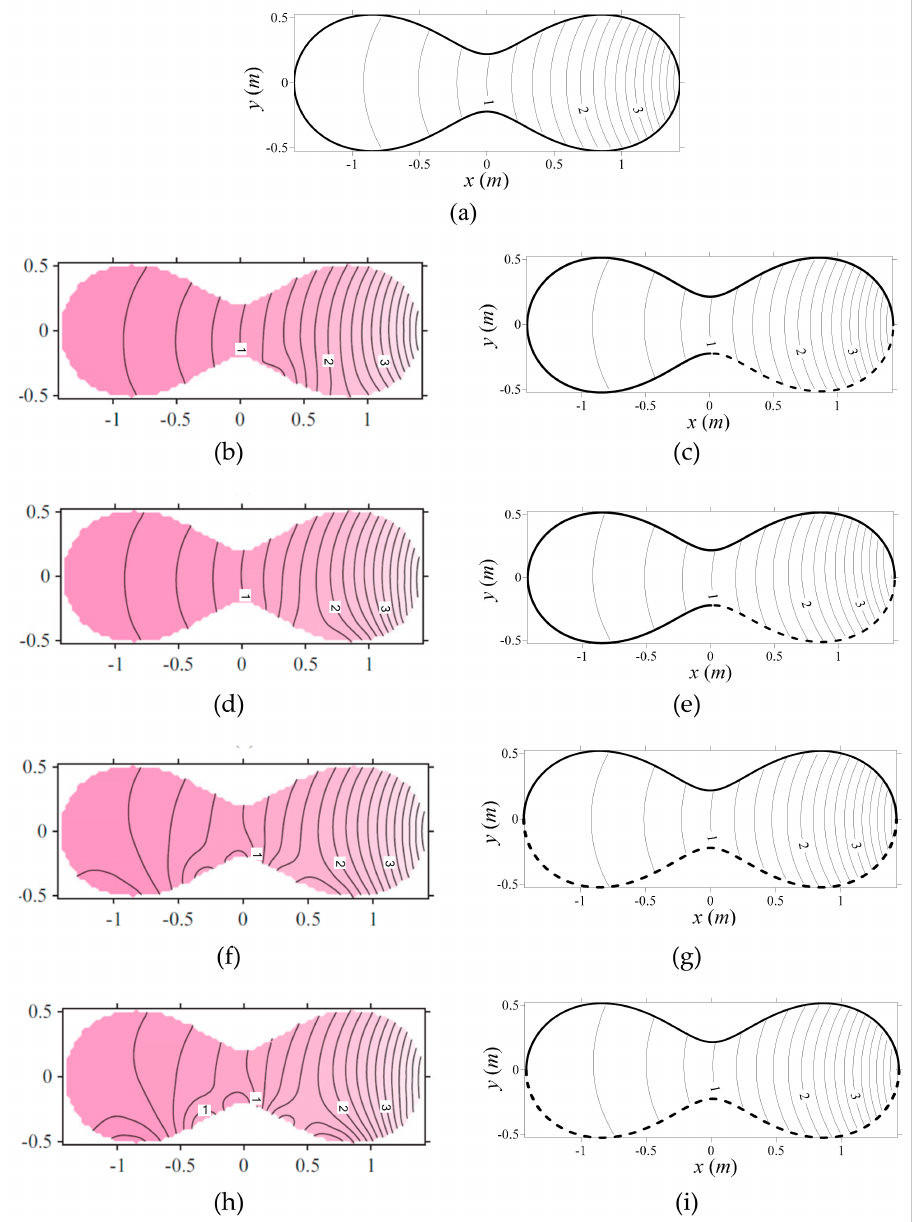
Figure 15. Comparison of the temperature fields of the proposed method and the MFS. ( a ) Analytical solution, ( b , c ) results with boundary data of θ values in the range of 0 ≤ θ ≤ 3/2 π with a noise level of s = 0, ( d , e ) the results with boundary data of θ values in the range of 0 ≤ θ ≤ 3/2 π with a noise level of s = 5, ( f , g ) the results with boundary data of θ values in the range of 0 ≤ θ ≤ π with a noise level of s = 0, and ( h , i ) the results with boundary data of θ values in the range of 0 ≤ θ ≤ π with a noise level of s =